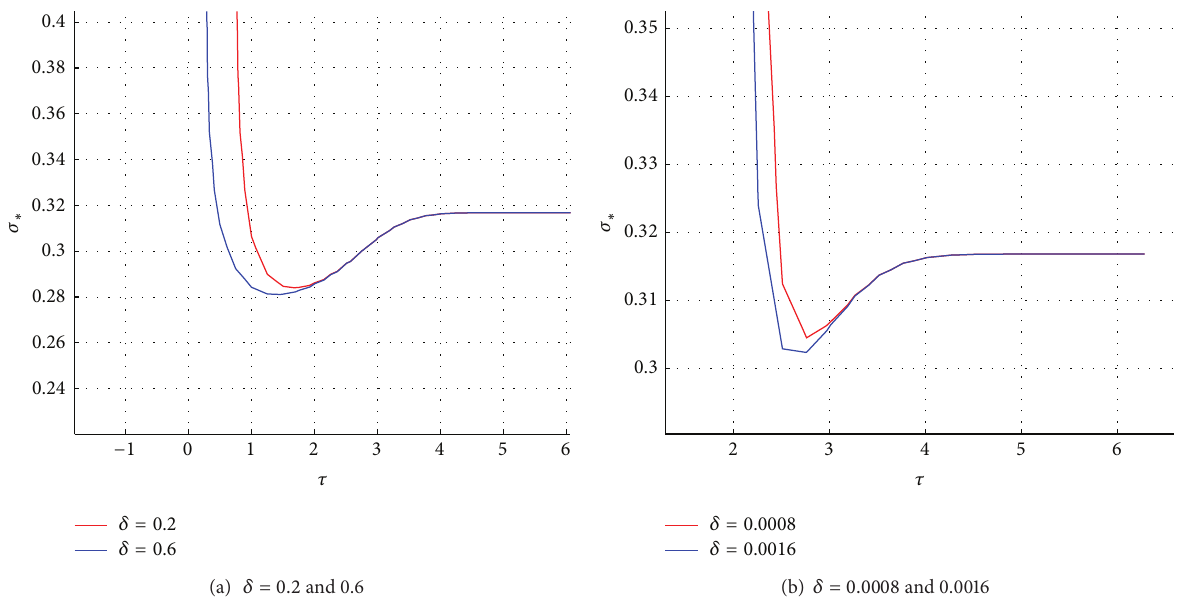
Figure 1: Fixed point 𝜎 ∗ versus optimal threshold 𝜏 𝑜 for ideal CAMP with 𝜎 = 0.23 ; undersampling ratios 𝛿 equal (a) 0.2, 0.6 and (b) 0.0008, 0.0016, respectively. Sparsity rate 𝜌 = 0.1 and the nonzero entries of vector 𝑥 have all amplitudes equal to 1 and phase uniformly distributed between −𝜋 and 𝜋